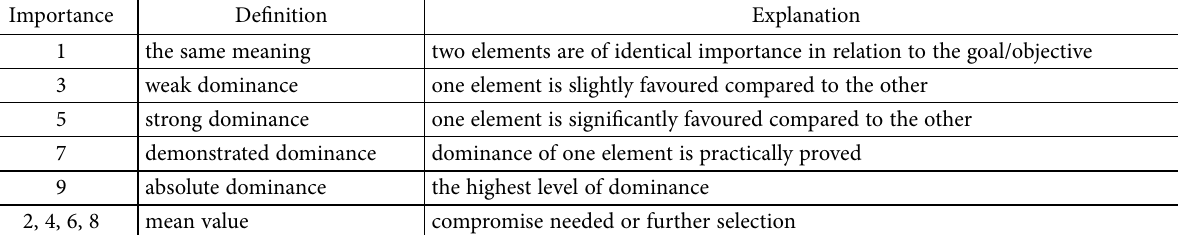
Table 2. Saaty’s scale of evaluation